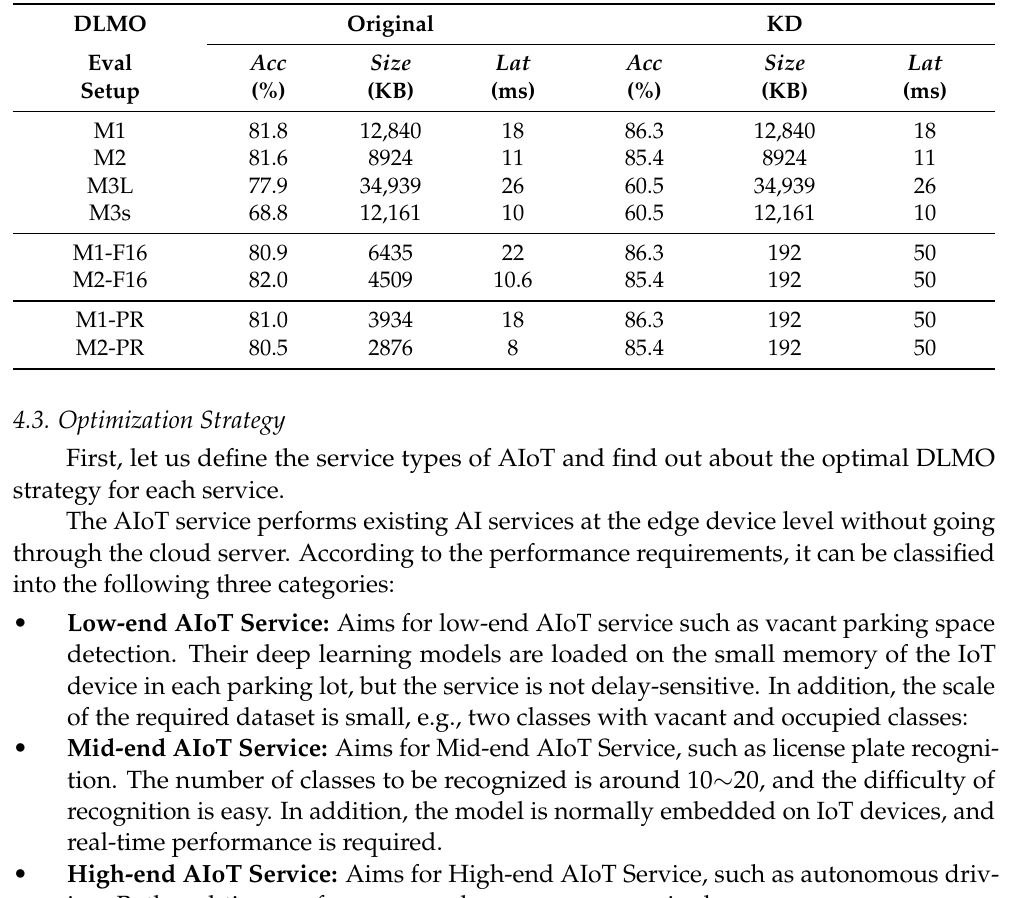
Table 14. Performance Evaluation of KD in the CIFAR10